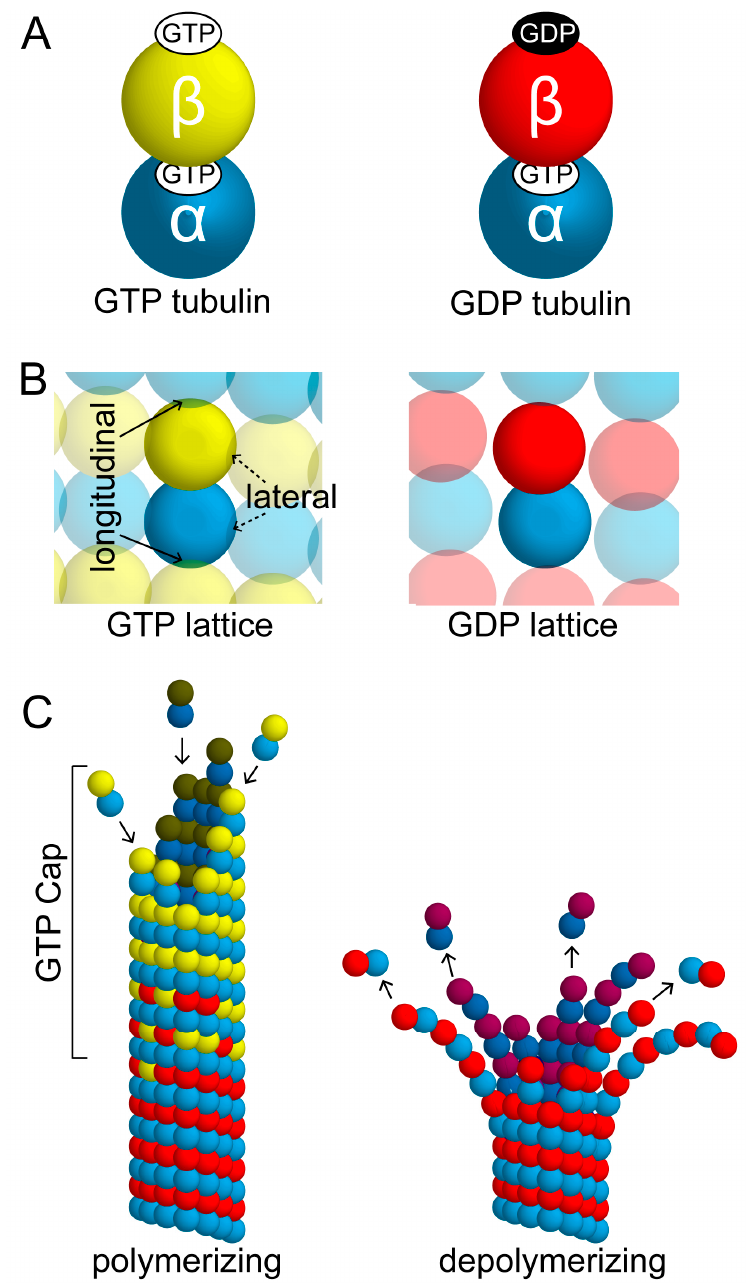
Figure 1. Microtubule structure and dynamics. ( A ) Heterodimer conformation in GTP and GDP states; ( B ) lattice conformation with labeled longitudinal and lateral interfaces; and ( C ) Microtubule conformation during polymerization and depolymerization.